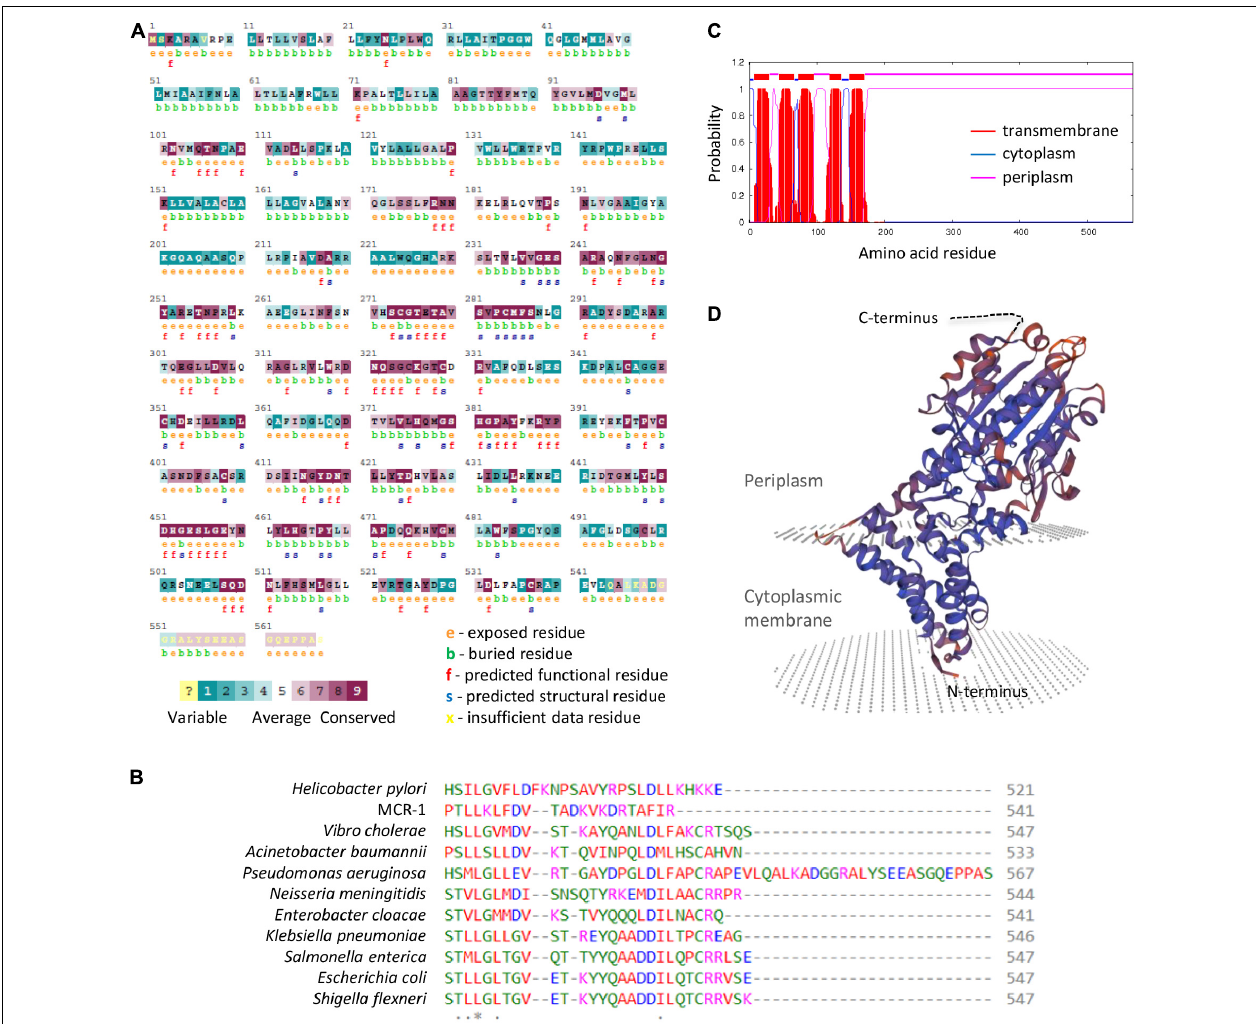
FIGURE 6 | (A) ConSurf analysis of evolutionary residue conservation in P. aeruginosa EptA. (B) Alignment of the C-terminus of selected EptA orthologs from the indicated bacteria. The MCR-1 protein has been included as control. The corresponding full-length alignment is shown in Supplementary Figure 3 . (C) Prediction of transmembrane helices in P. aeruginosa EptA by TMHMM. (D) Modeling of the P. aeruginosa EptA structure by SWISS-MODEL using the N. meningitidis EptA protein (PDB 5FGN) as the template. The C-terminal tail of P. aeruginosa EptA cannot be modeled and is represented as a dashed black line.